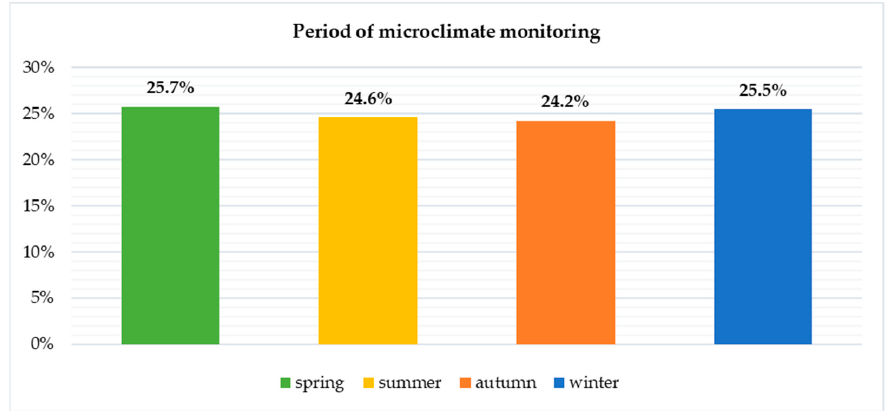
Figure 7. Comparison of the seasons in which microclimate monitoring took place.